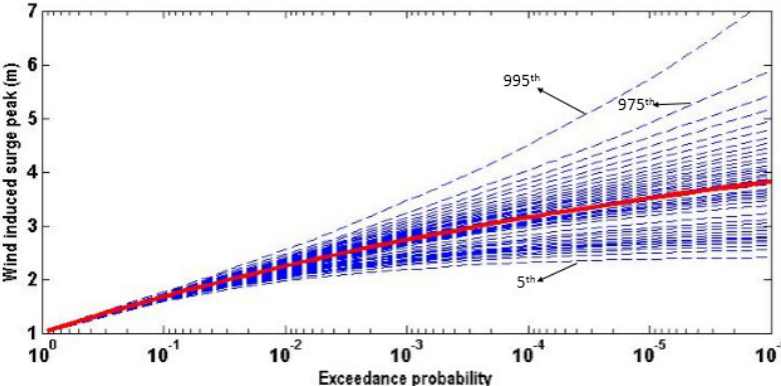
Figure 5. Selected bootstrap quantiles for wind induced surge h smax .